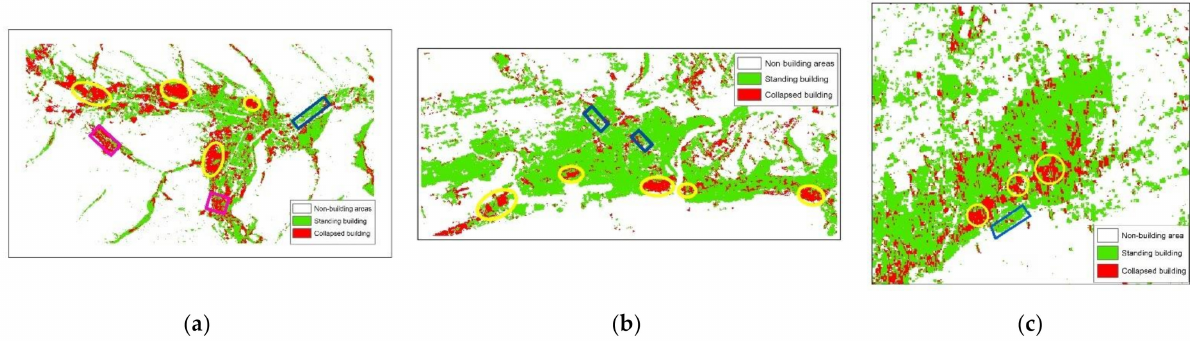
Figure 28. The detection results of the proposed method in different study sites: ( a ) the detection result of the Radarsat-2 PolSAR data in the Yushu study site; ( b ) the detection result of the ALOS-1 PolSAR data in the Ishinomaki study site; ( c ) the detection result of the ALOS-2 PolSAR data in the Mashiki town study